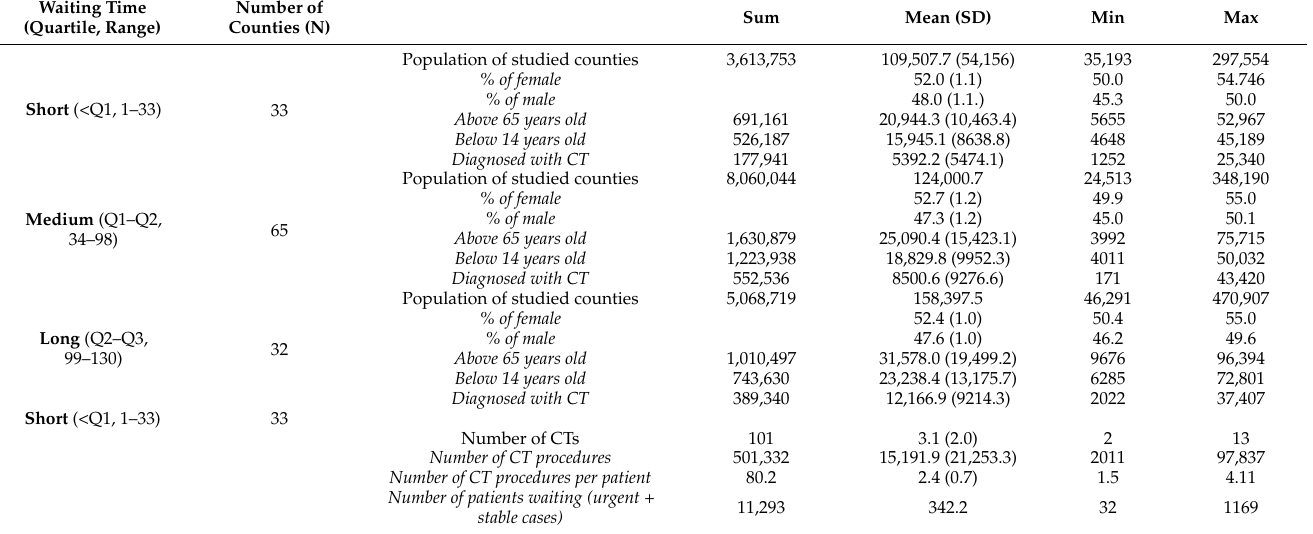
Table 1. General characteristics of the Polish utilization of CT scanners for 130 counties included in the study categorized into three groups by the waiting time for CT procedure